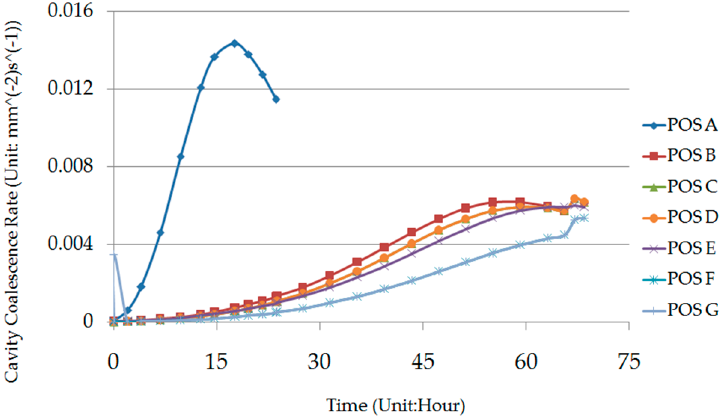
Figure 13. Evolution of the cavity density (POS B).